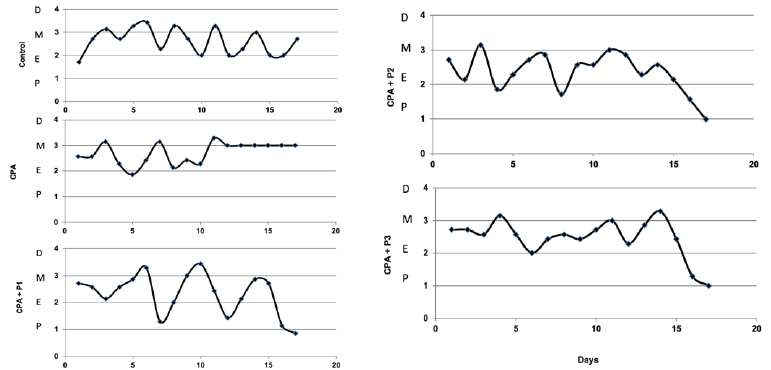
Figure 3. Sex hormone levels in serum — ( a ) FSH and ( b ) E2 of Control, CPA, and CPA + P1/P2/P3 exposed animals. Data represent mean ± SEM; One- way ANOVA followed by Bonferroni’s Multiple